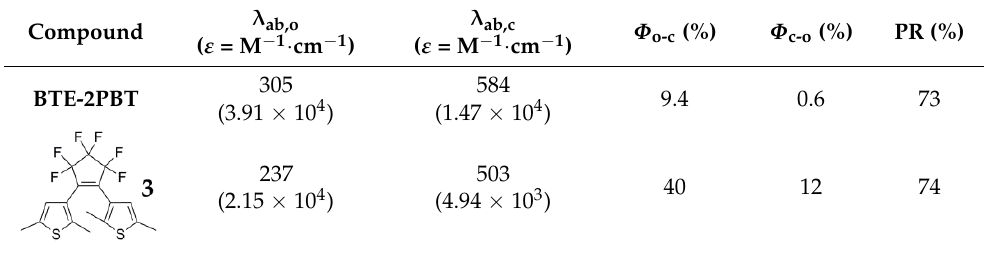
Figure 1. Photochromic properties of BTE-2PBT triad. ( a ) Photochromic reactions of BTE-2PBT ; ( b ) Photochromism of BTE-2PBT in solid state; ( c ) Absorption change and fatigue resistance of BTE-2PBT in hexane (2.0 × 10 − 5 M) upon photo- chromism; ( d ) Absorption change and fatigue resistance of BTE-2PBT in PMMA film (5 wt %) upon photochromism. 2.3. Photophysical and AIE Properties of BTE-2PBT The absorption and photoluminescence (PL) properties of BTE-2PBT in solution, solid state, and film are summarized in Table 2. The absorption peak of BTE-2PBT in hex- ane appearsat 388 nm and arises from π – π * transition. The absorption peak of film sample shows up at 385 nm, whereas that of solid sample redshifts to 413 nm. The data in Table 2 show that the triad is very dim in solution, but exhibits significant fluorescence in solid state and film when excited by 365 nm UV. The fluorescence lifetimes ( τ ) of BTE-2PBT in solid state and film show correlation with their fluorescence quantum yields. Comparison with a reference PBT AIEgen ( 4 ) shows that the excitation